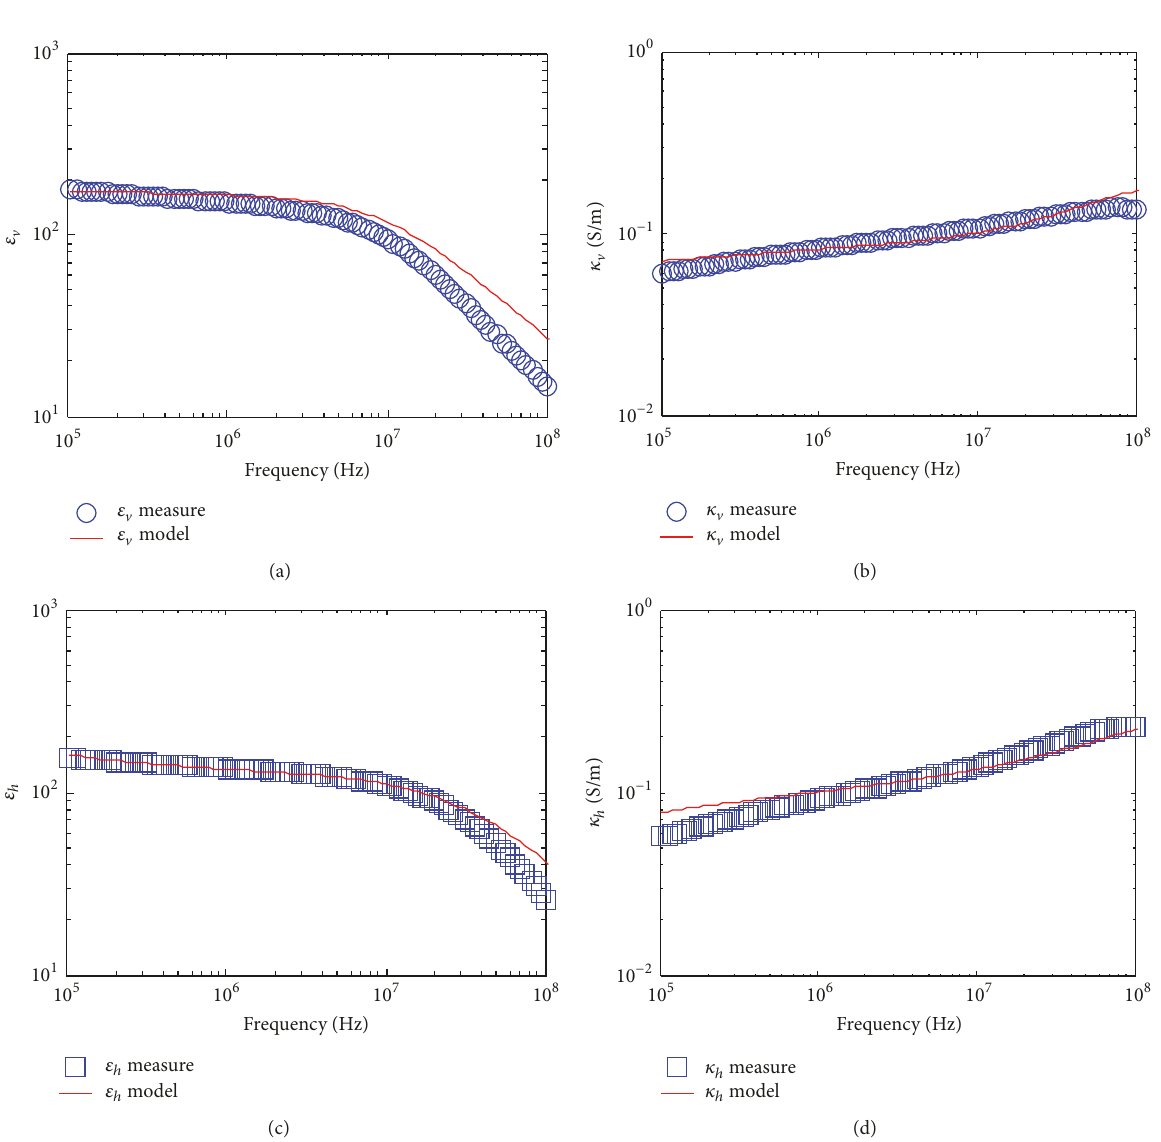
Figure 7: Comparison of the experimental measurements with the modeling results for the artificial shale sample A4060 75. The correlation coefficients are R = 0.9921 and R = 0.9433, respectively, for the relative permittivity and conductivity in the vertical direction and R = 0.9971 and R = 0.9943 for the relative permittivity and conductivity in the horizontal direction,